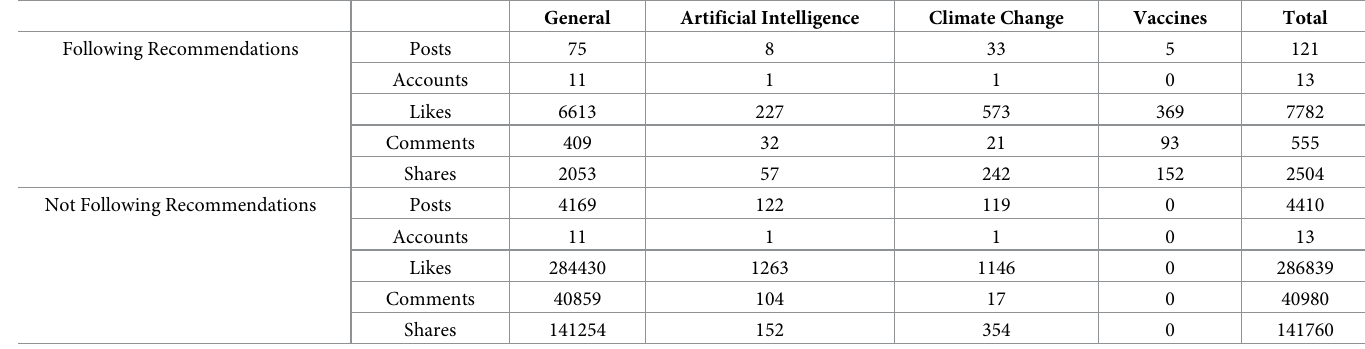
Table 3. Facebook. Count of posts, accounts and reactions to Facebook posts categorised by their compliance with the introduced